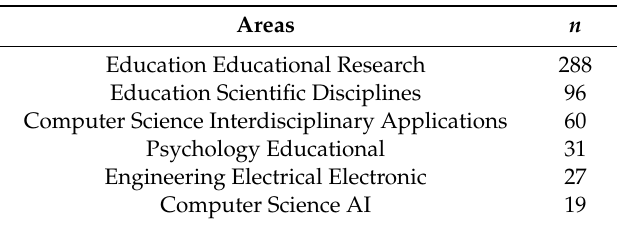
Table 3. AI publication areas.